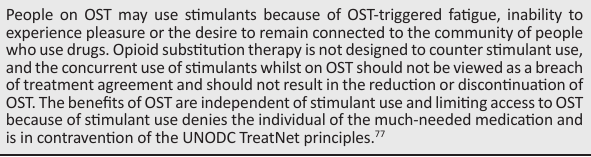
BOX 17: Stimulant drug use by people on opioid substitution therapy. 51